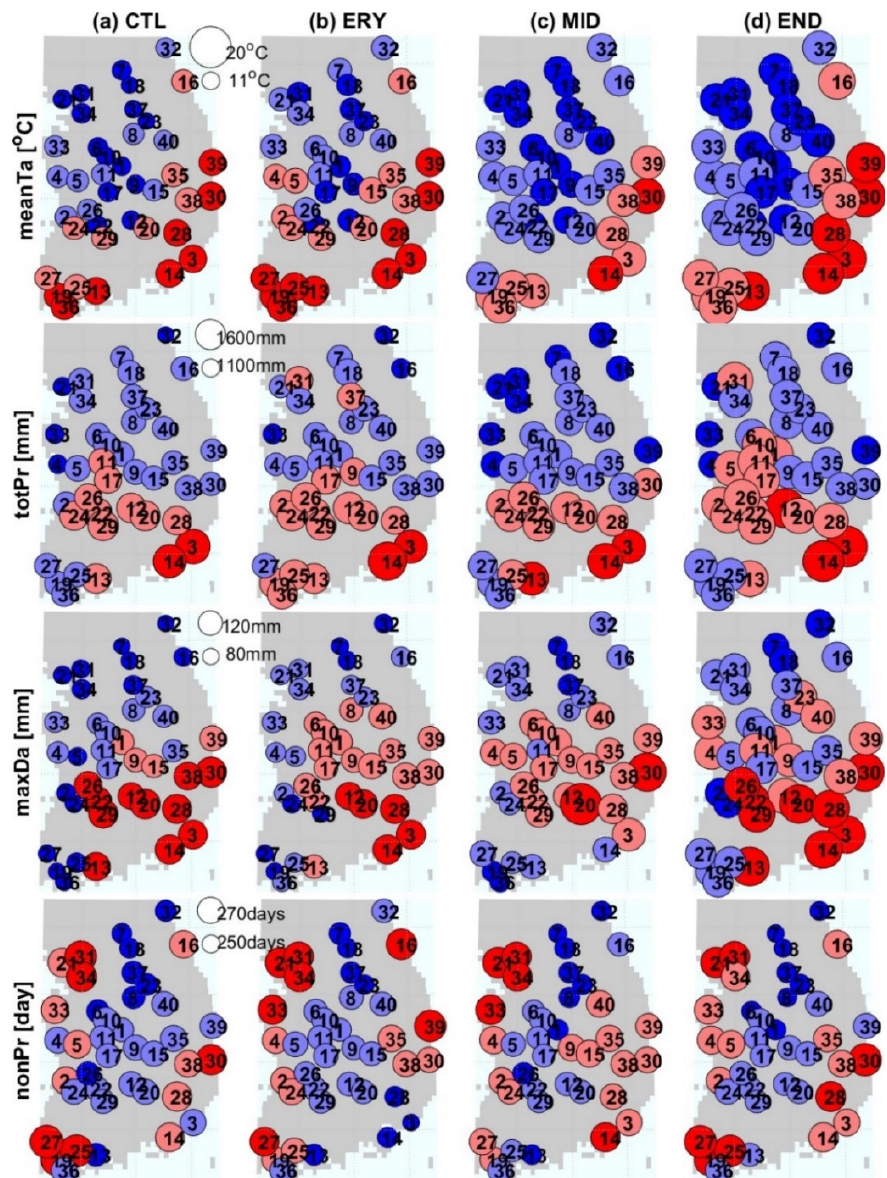
Figure 4. Spatial distribution of the CM values across South Korea for ( a ) CTL, ( b ) ERY, ( c ) MID, and ( d ) END period for the SSP5-8.5 emission scenario. The 4 indices were illustrated for the entire year. Spatially, 40 locations are classified into 4 distinct clusters (from the smallest (dark, blue-colored circles) to the largest cluster (red-colored circles)), by applying the K-means algorithm.